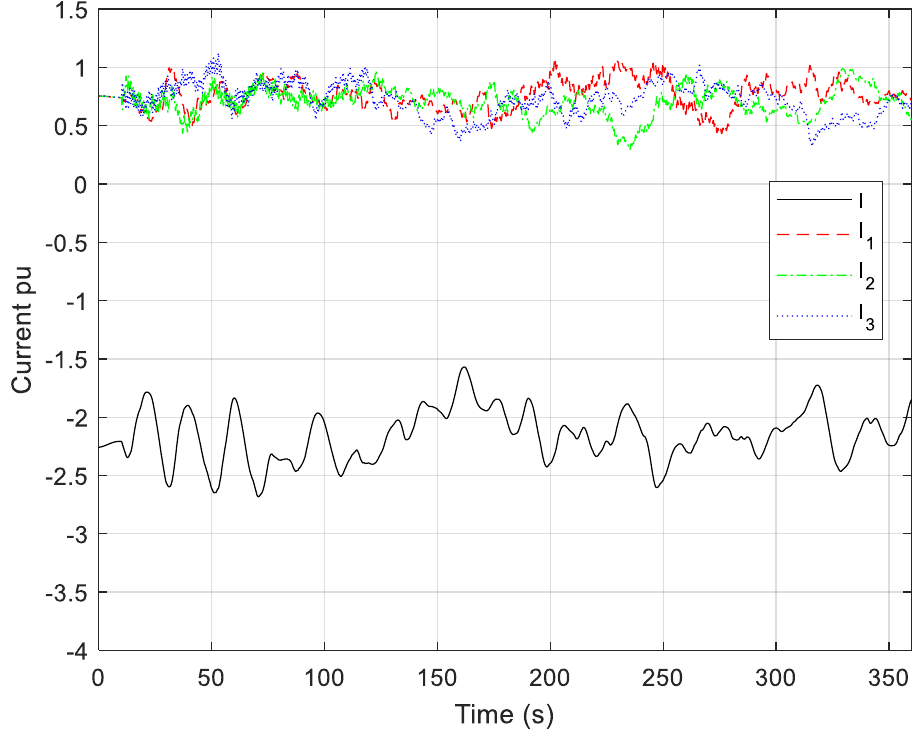
Figure 27. Current of the B2B converter and currents of PMSGs (random wind disturbance).